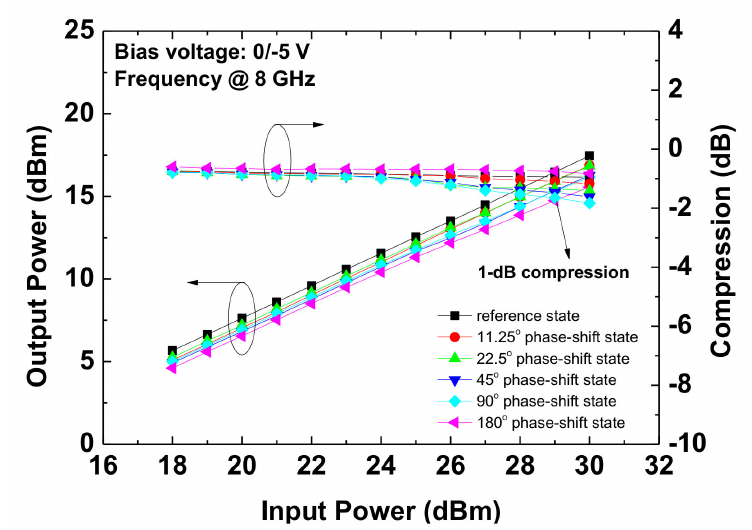
Figure 11. Measured power handing of the phase shifter.